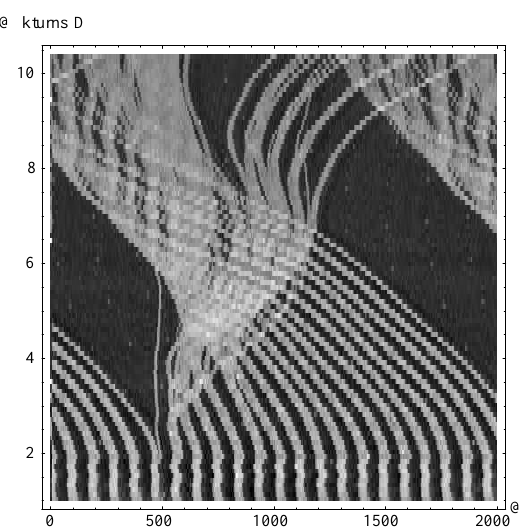
FIG. 10. 1.8 3 10 12 protons, one trace each 100 turns, vertical span 16.7 ms, V rf (cid:1) 0.3 keV.